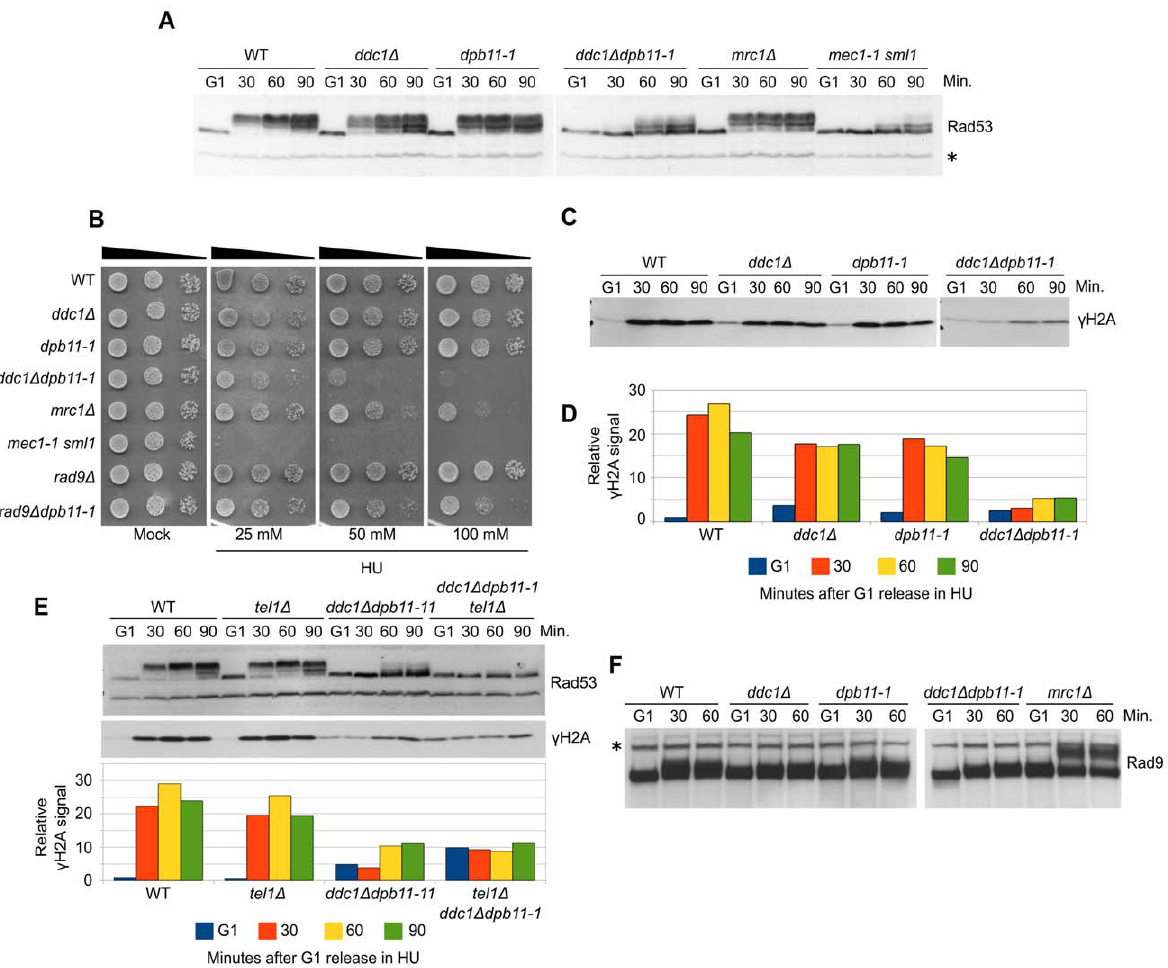
Figure 2. Dpb11 and 9-1-1 independently activate Mec1 after replication stress. (A) K699 (WT), YFP20 ( dpb11-1 ), YAN21/8d ( ddc1 D ), YFP62/ 1d ( ddc1 D dpb11-1 ), YFP125/6d ( mrc1 D ) and YMIC5A3 ( mec1-1 ) strains were grown to mid-log phase, synchronized in G1 with a -factor and released into fresh medium supplemented with 200 mM HU. At the indicated time-points, protein extracts were prepared and separated by SDS-PAGE. Rad53 activation was assayed as the phosphorylation-dependent shift of the protein. (B) 10 3 –10 4 cells from overnight cultures of the strains analyzed in panel A and YFP74 ( rad9 D ) and YFP161/5C ( rad9 D dpb11-1 ) were spotted on YPD plates supplemented with HU at the indicated concentrations. Cell survival was assayed after 2–7 days. (C) The same filter in panel A was probed for Mec1 activation by analyzing the level of histone H2A phosphorylation. (D) Quantification of c H2A in the experiment shown in panel C, using a -Rad53 cross-reacting band as loading control. The values indicate the fold increase respect to the WT G1 sample. (E) Strains K699 (WT), YMIC6C3 ( tel1 D ), YFP62/1d ( ddc1 D dpb11-1 ) and YFP230 ( ddc1 D dpb11- 1tel1 D ) were synchronized in G1 and released into fresh medium supplemented with 200 mM HU. At the indicated time-points Rad53 and H2A phosphorylation were assayed by western blotting. A quantification of the signal is shown in the lower panel, using a -Rad53 cross-reacting band as loading control. The numbers indicate the fold increase respect to the WT G1 sample. (F) The same extracts of panel A were probed with a -Rad9 antibodies to determine the extent of Rad9 hyperphosphorylation. In all the relevant panels the loading control is indicated by an